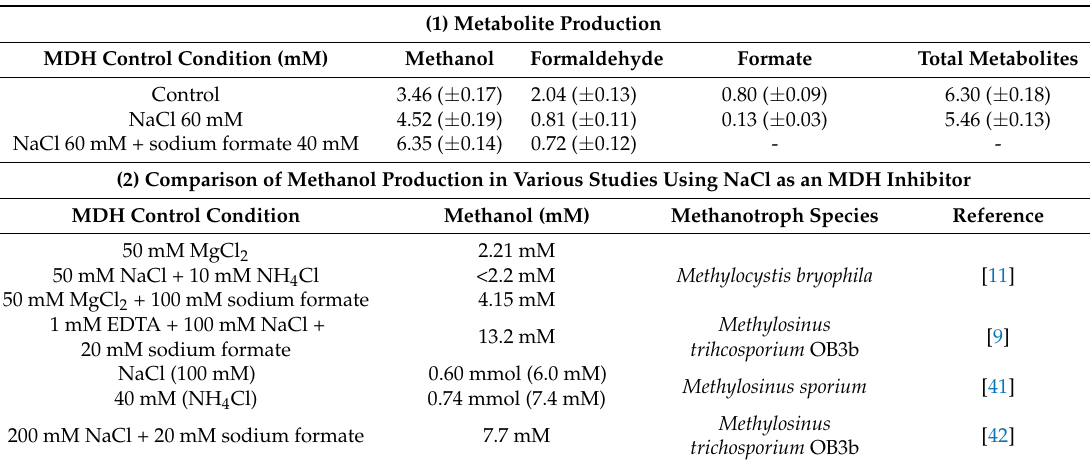
Table 2. Concentrations of methanotroph metabolites (methanol, formaldehyde, and formate) in NMS medium according to the NaCl concentration (1) and comparison of methanol production among studies using NaCl as an MDH inhibitor (2).